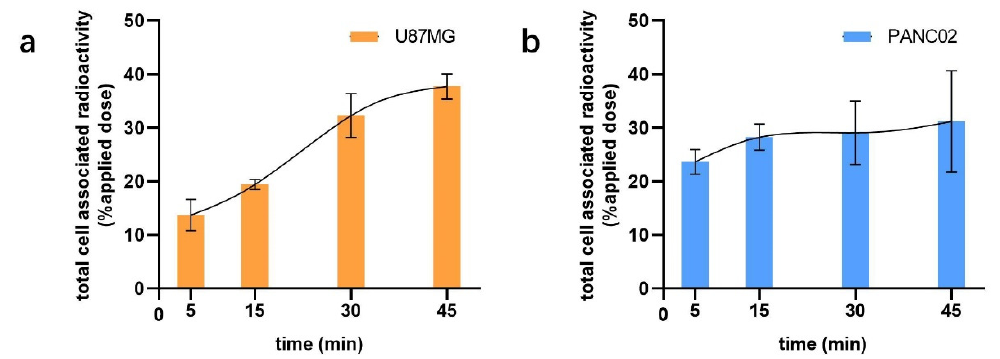
Figure 2. Binding capacity of 68 Ga-WL12 to U87MG ( a ) and PANC02 ( b ) cells after incubation for 5, 15, 30, and 45 min.